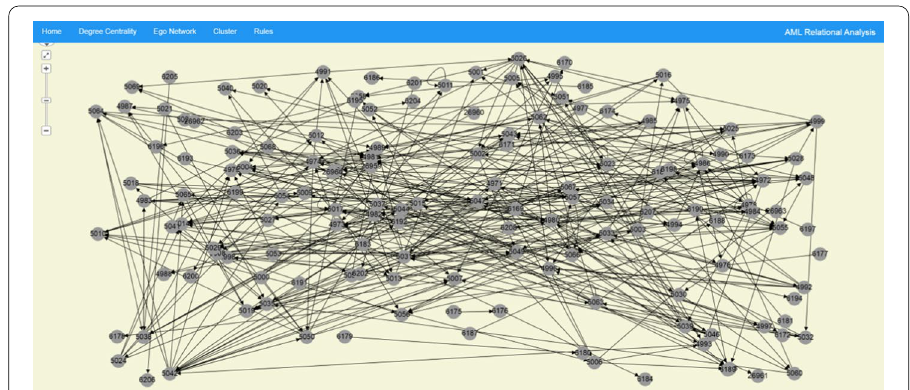
Fig. 4 Network of 100 suspicious and non‑suspicious customers